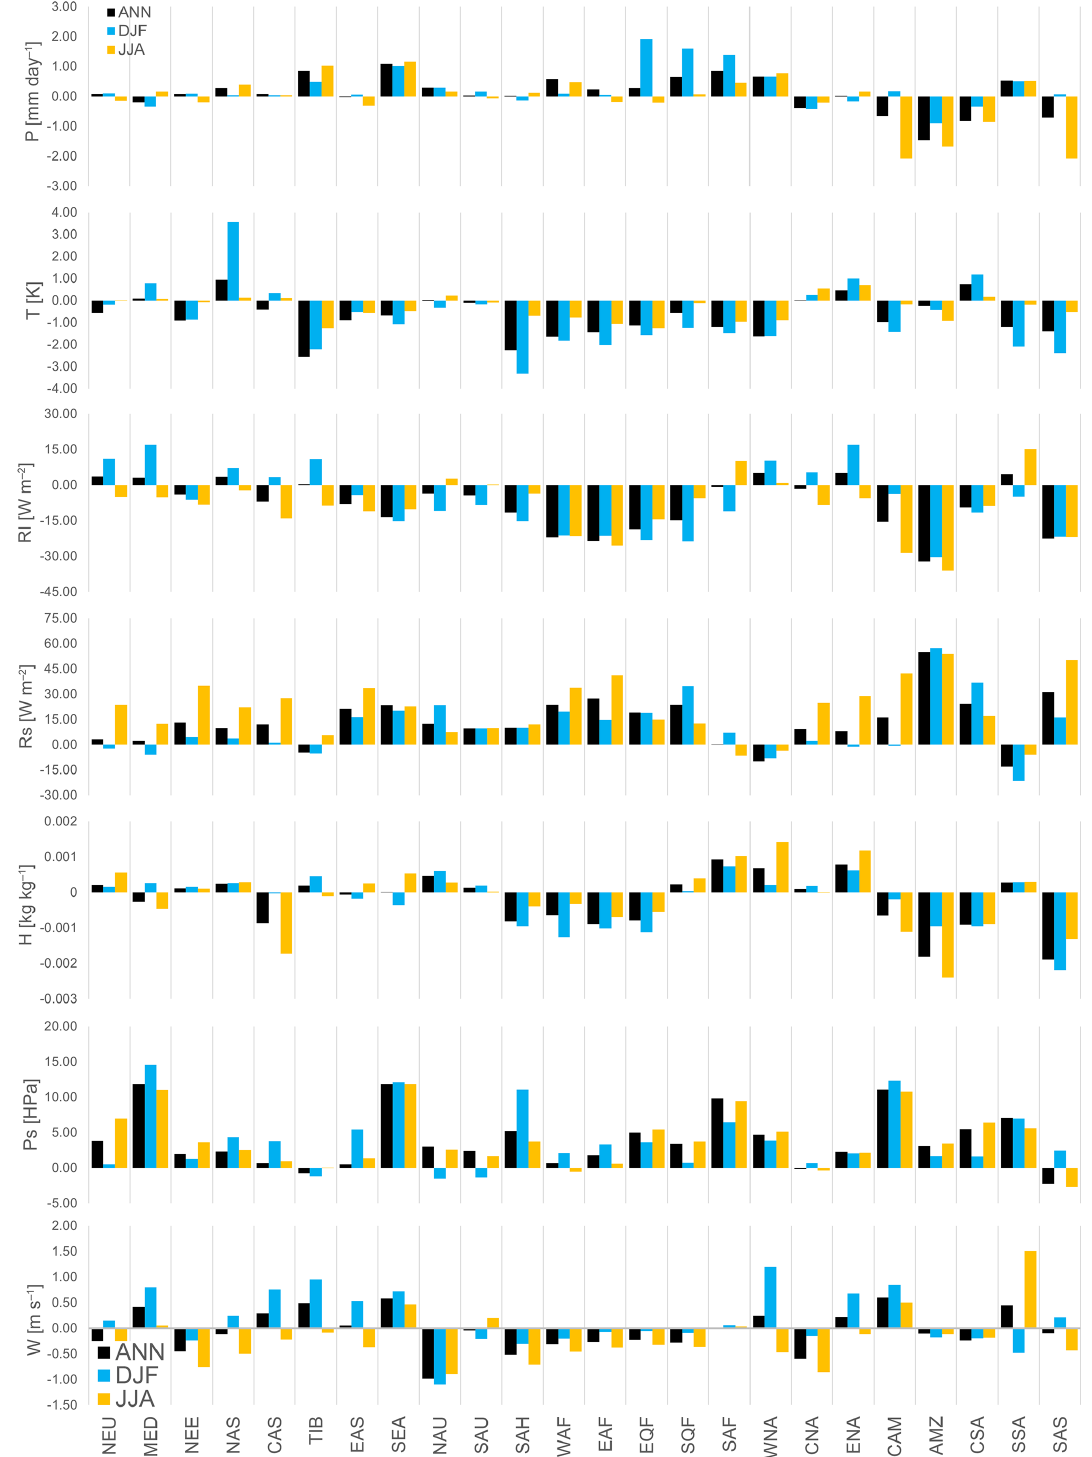
Figure 5. Initial biases (raw-WFDEI) of the GCM ensemble forcing variables, spatially averaged for 24 Giorgi regions. Biases are calculated between long-term annual averages (ANN) and December–January–February (DJF) and June–July–August (JJA) averages of the period